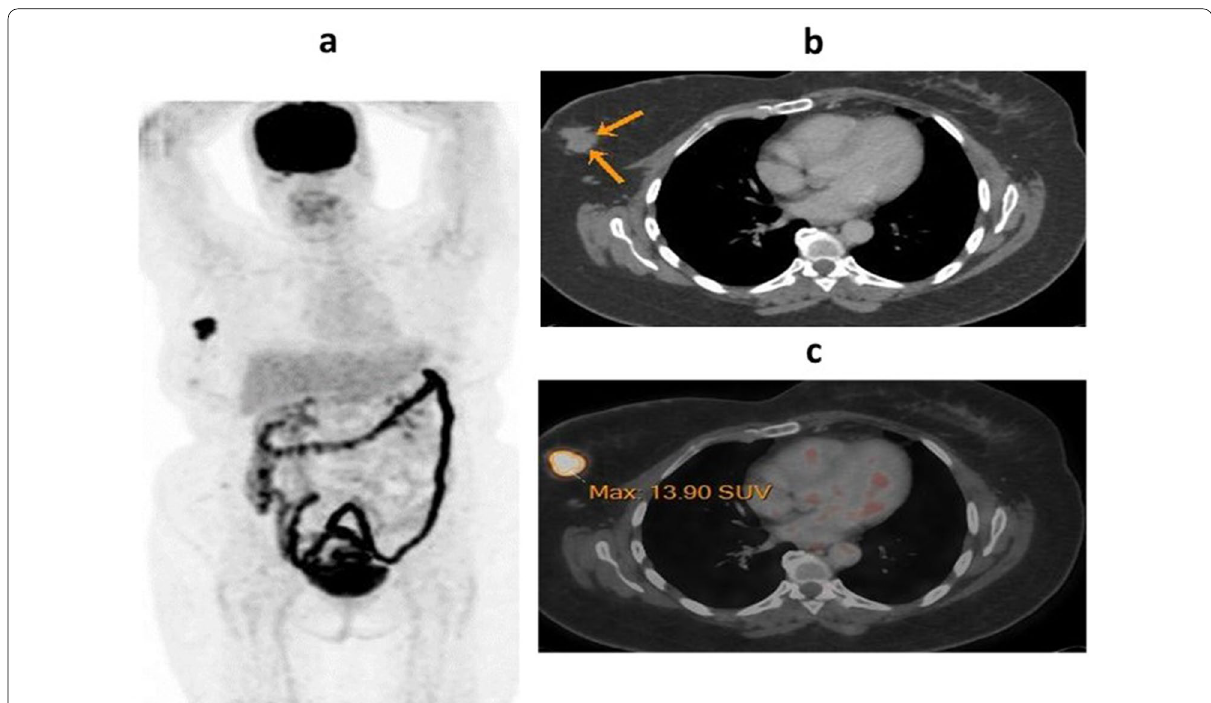
Fig. 4 A 55-year-old female patient arrived with newly diagnosed right breast cancer (adenoid cystic carcinoma). a A whole-body PET MIP picture indicated an active right breast lesion with no additional hypermetabolic lesions found anywhere else on the body. b , c Axial CECT and fused PET/ CT images revealed speculated hypermetabolic soft tissue lesion at upper outer quadrant of the right breast, measuring about 23 achieving up to 13.9